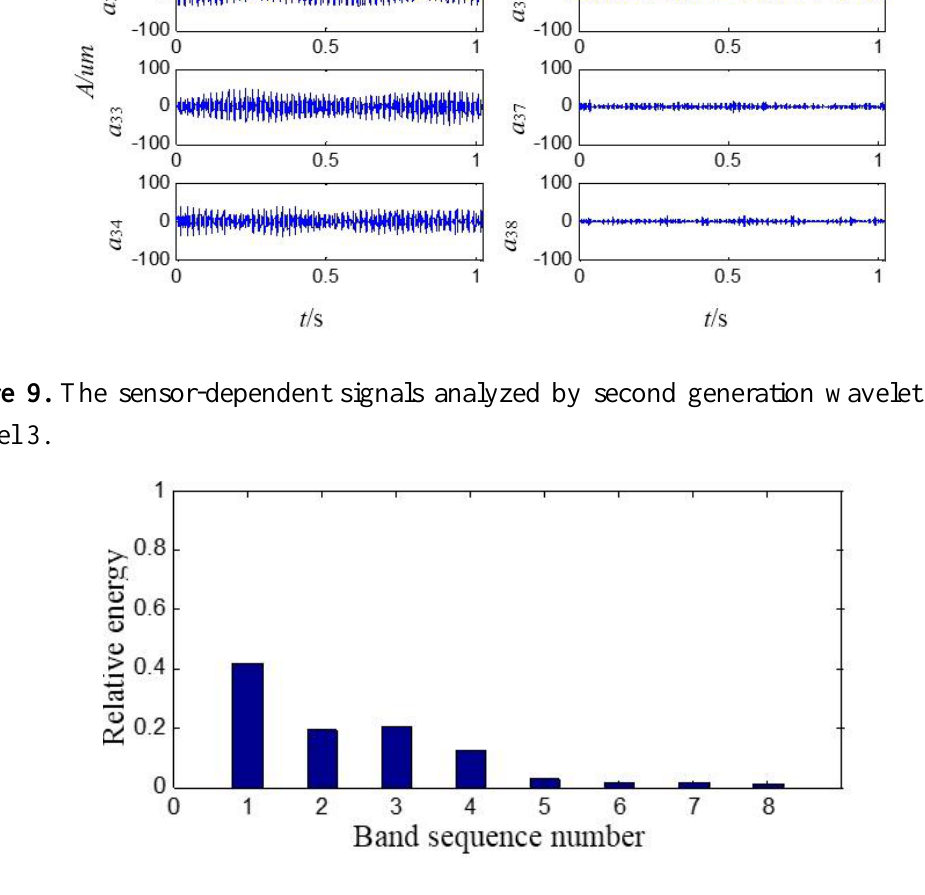
Figure 10. The sensor-dependent signal’s relative energy distribution in level